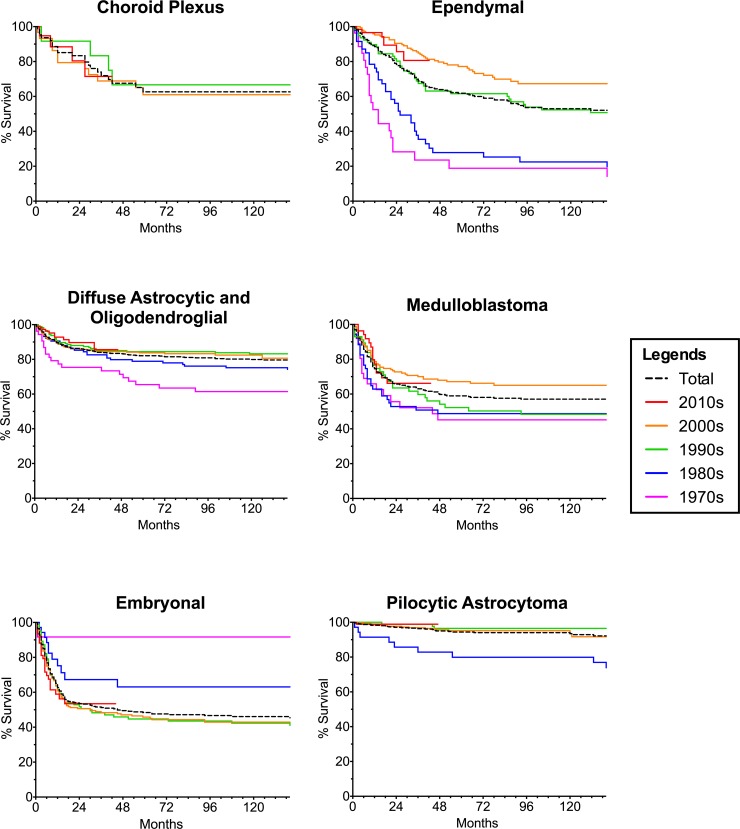
Survival of infantile brain tumor subtypes by decade.KM curves showing survival of each tumor subtype by decade. Each color represents a different decade, and the black dotted line represents average survival from 1973–2013. Corresponding 1, 5, and 10 year survivals are found in S7 Table.